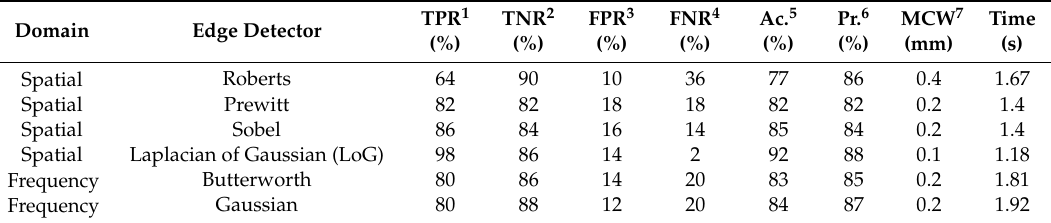
Table 1. Performance of di ff erent edge detectors in the proposed crack detection algorithm.